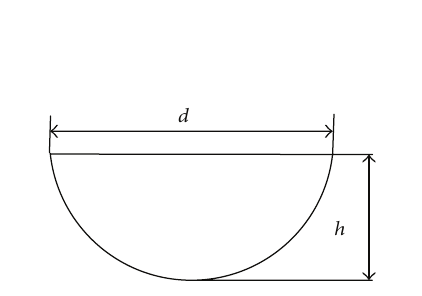
Figure 5: Relationships among slip ratio, velocity, and tread pattern obtained by experiment.